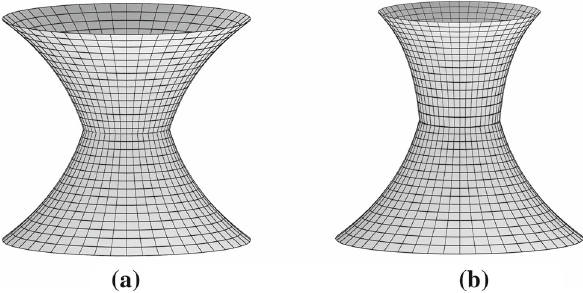
Fig. 1 Schematic embedding diagram for a symmetric TSW ( a ) and an ATSW ( b ). The throat, on minimum radius hypersurface, separates two asymptotically flat spacetimes that are not the mirror images of each other. The upper and lower hyperboloids represent spacetimes with unequal matter content, joined at the throat in accordance with the junction conditions. Obviously, the slopes of tangent vectors to the hyperboloids at the throat are not